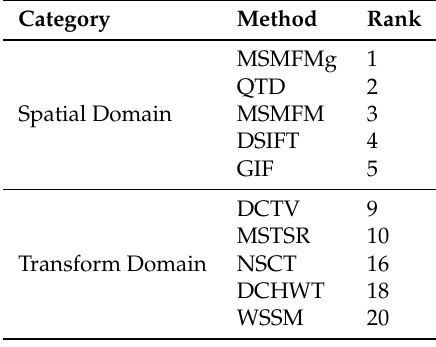
Table 9. Five best performing MIF algorithms in each category; spatial domain and transform domain.